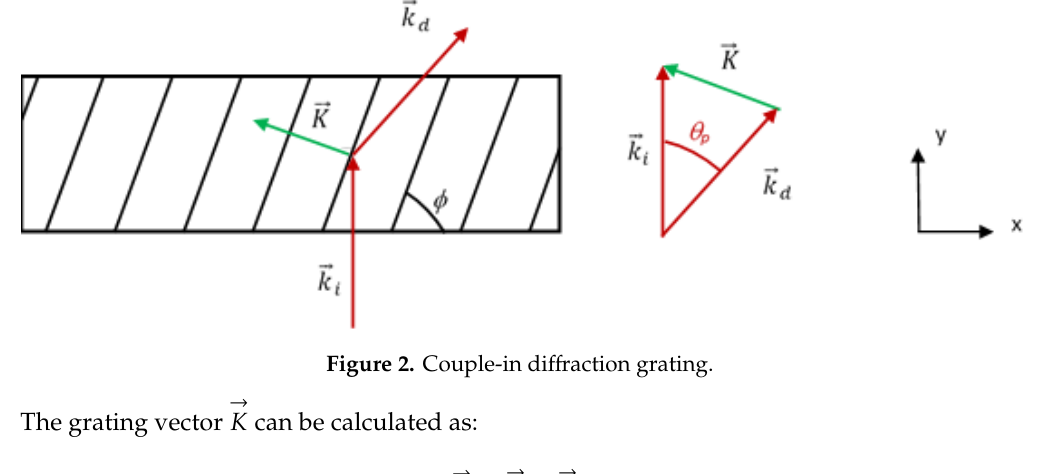
Figure 2. Couple-in diffraction grating.